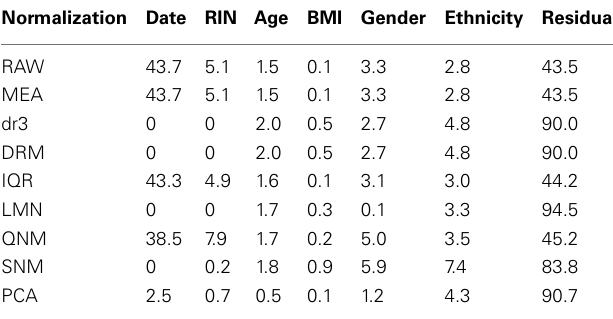
Table 1 |Variance component analyses.